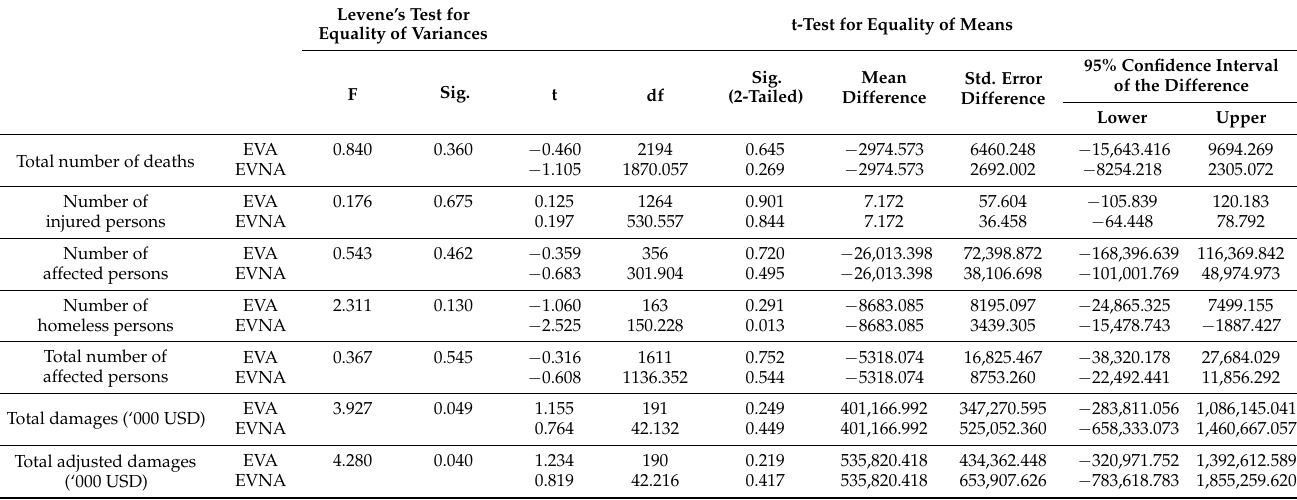
Table 6. The results of Student’s t-test group comparison between US and rest of the world. Levene’s Test for Equality of Variances t-Test for Equality of Means